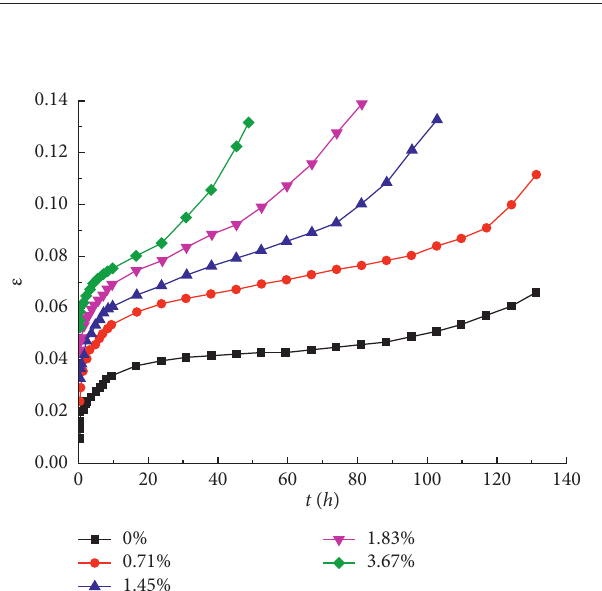
Figure 8: Experimental triaxial creep data under different moisture content